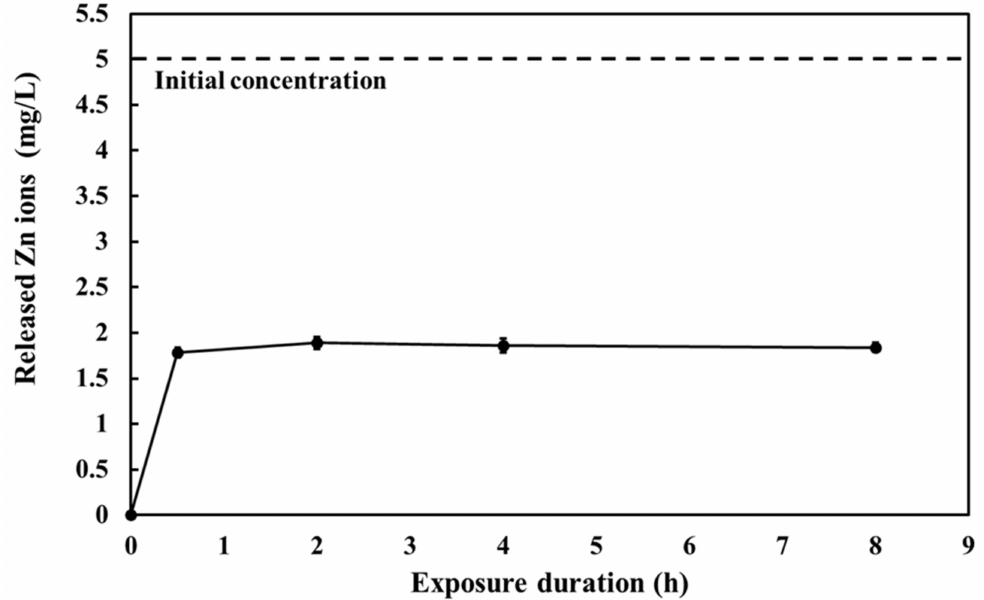
Figure 1. Released Zn ions from ZnO-NPs in LB medium. Initial concentration of ZnO-NPs sus- pension was 5 mg/L prepared in LB medium. Samples were incubated at 37 ◦ C and analyzed at different time points at 0, 0.5, 2, 4, and 8 h. Samples were filtered to remove undissolved ZnO-NPs, and then the concentrations of Zn ions in the aqueous phase were measured using ICP-AES. The data are shown as the mean ±